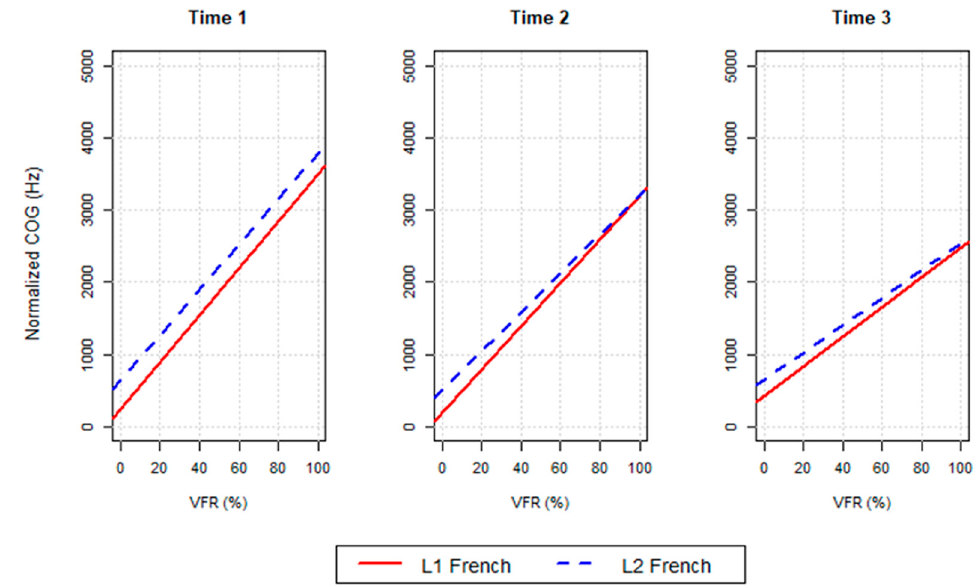
Figure 4. COG by speaker group and FVR at all timepoints.